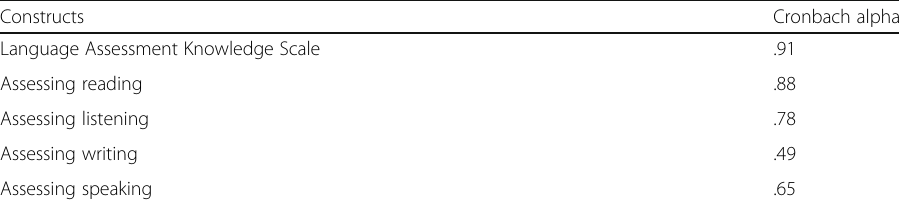
Table 5 Reliability analysis for Language Assessment Knowledge Scale (LAKS) and its sub-